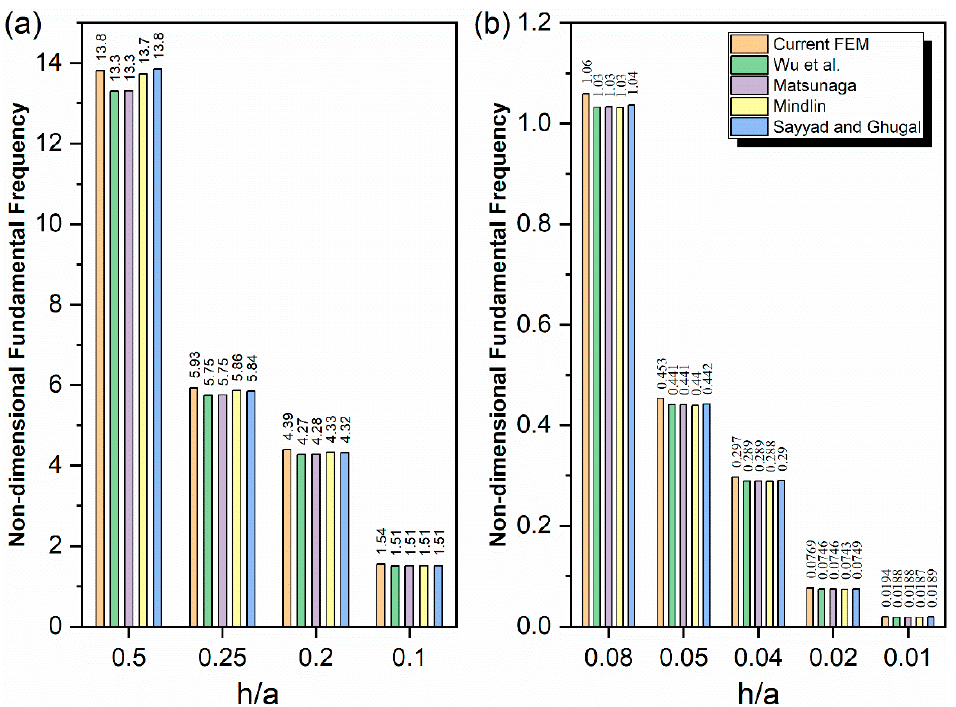
Figure A1. Comparison of non-dimensional fundamental frequencies computed by current FEM and values reported by various researchers [43–46]. ( a ) moderately thin plates having h/a between 0.5 to 0.1 ( b ) thin plates having h/a between 0.08 to 0.001.